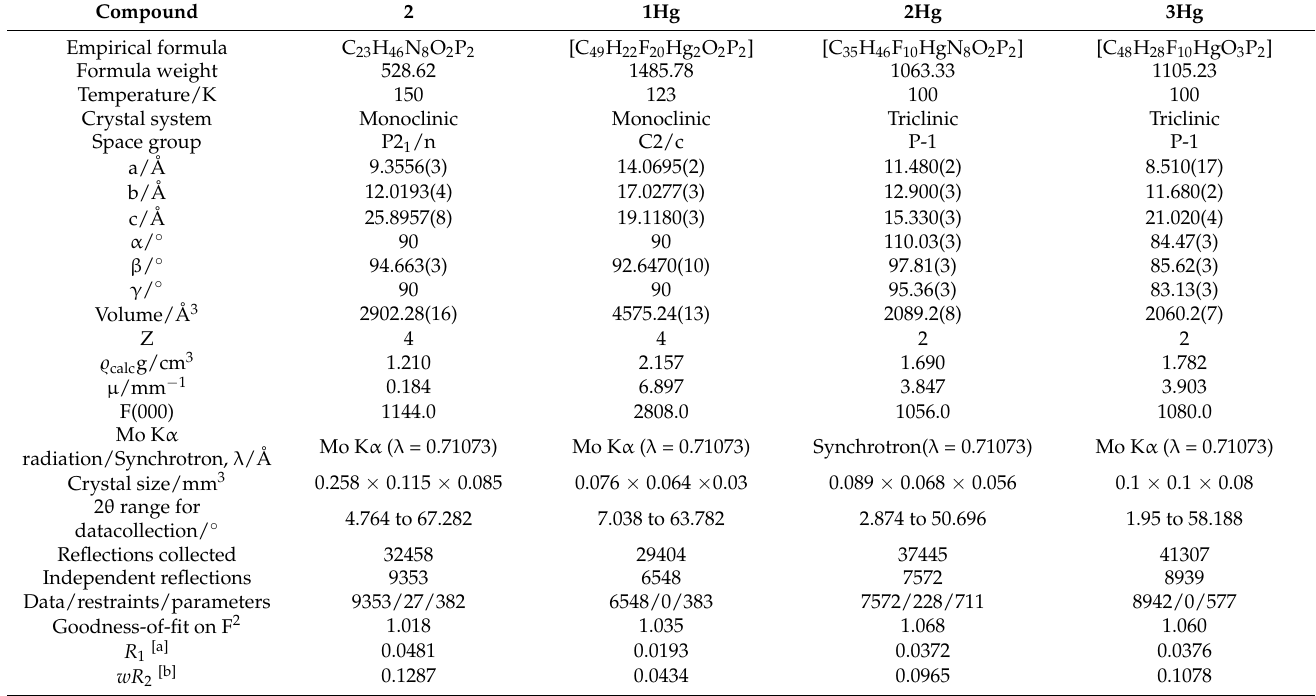
Table 5. Crystallographic